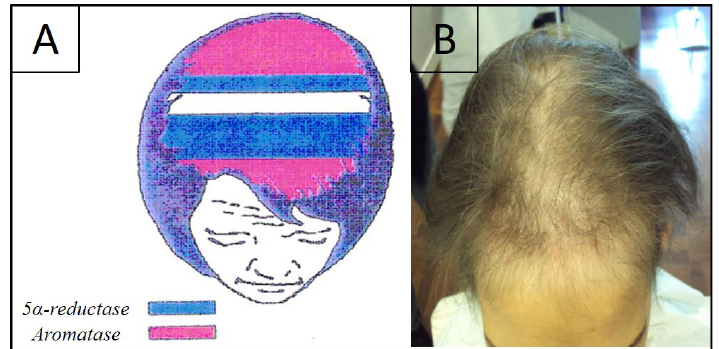
areas in blue represent the zones where 5α-reductase is higher; B) clinical aspect of alopecia induced by hormonal anticancer therapy. It shows the recession of the frontal-temporal hairline and a certain grade of hair miniaturization in the same area and also in the central scalp